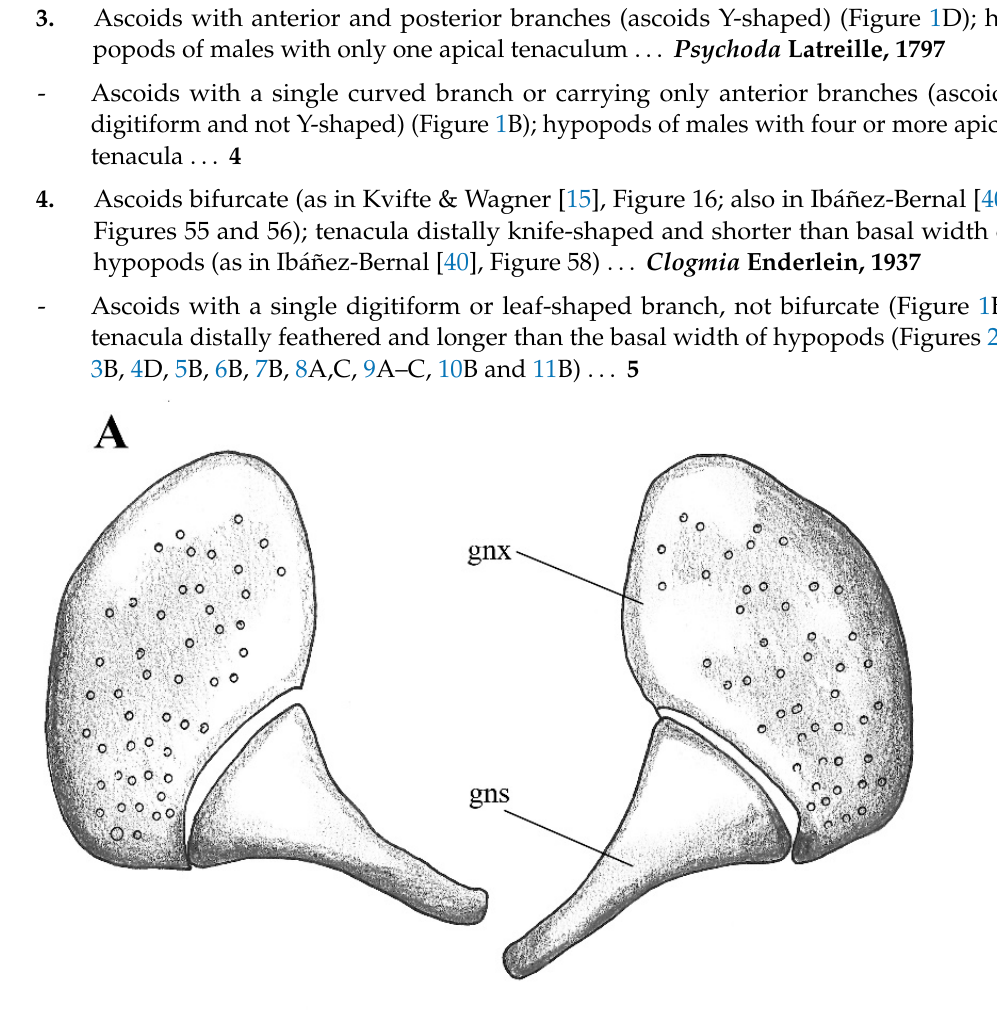
Figure 2. Lepiseodina latipennis (Sarà 1953), male genitalia adapted from the original description by Sarà (1953). ( A ). Gonocoxites and gonostyli. ( B ). Hypopods and hypoproct. Abbreviations: gnx = gonocoxite, gns = gonostyli, hpd = hypopod, epi = epiproct, ten = tenacula. No scale available based on original drawing.